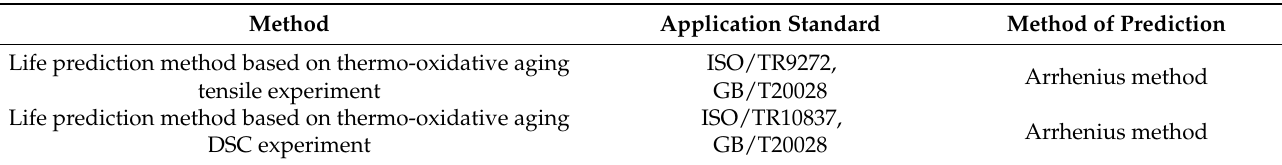
Table 4. Life prediction methods and standards for PE